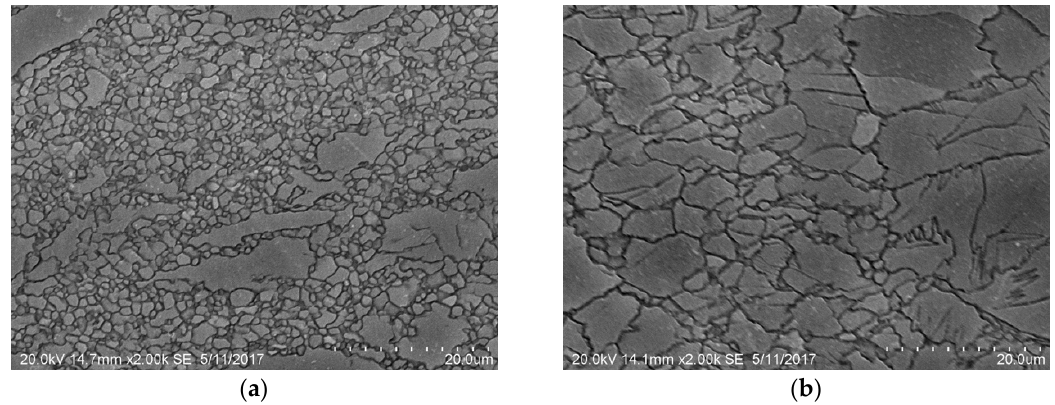
Figure 12. Microstructures of AZ31 after one ECAE pass at temperatures of 250 °C ( a ) and 275 °C ( b ). The large grains in ( a ) are oriented along the extrusion direction.